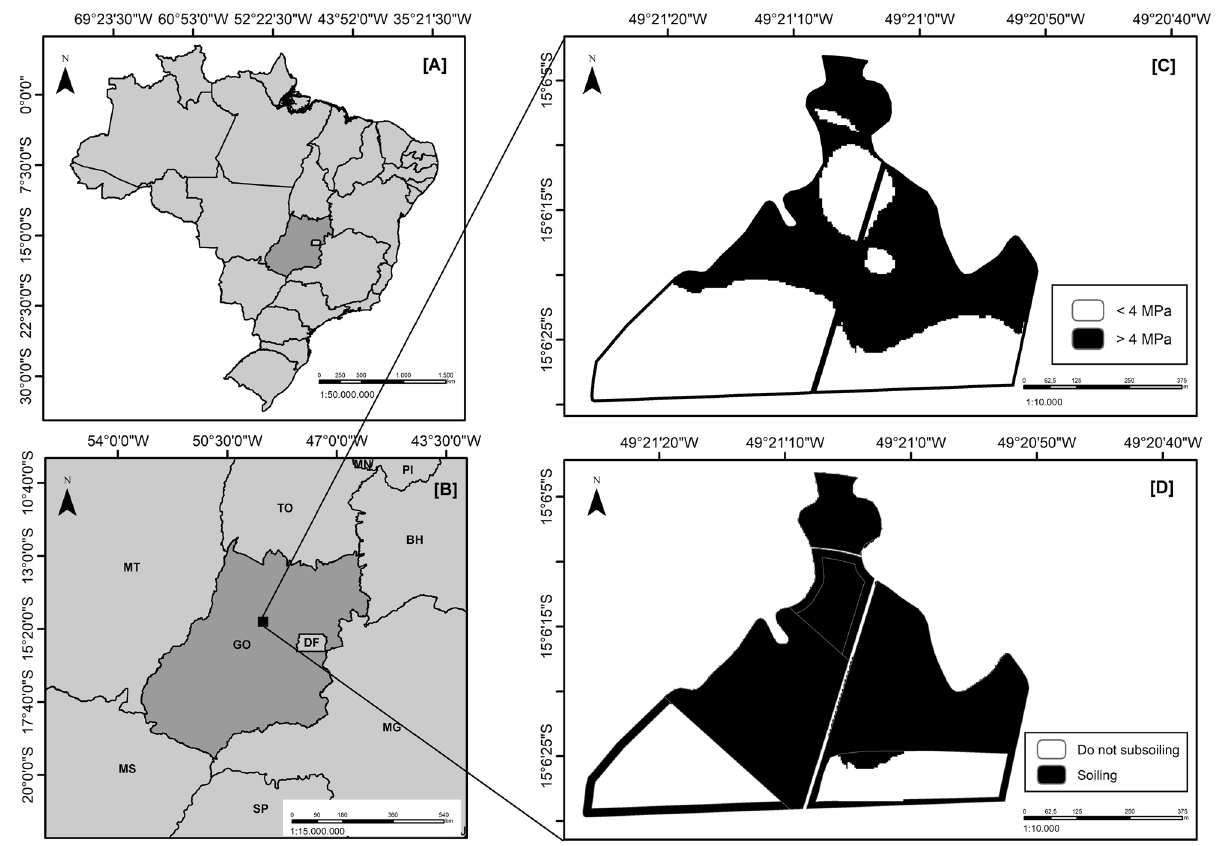
Figure 2. Kriging map of soil mechanical resistance to penetration in areas cultivated with sugarcane ( A ) and operational map for soil preparation with subsoiling ( B ). (Data and maps produced by the author. Generated by ArcGIS 10.2, http:// www. esri. com/ softw are/ arcgis/ arcgis- for- deskt